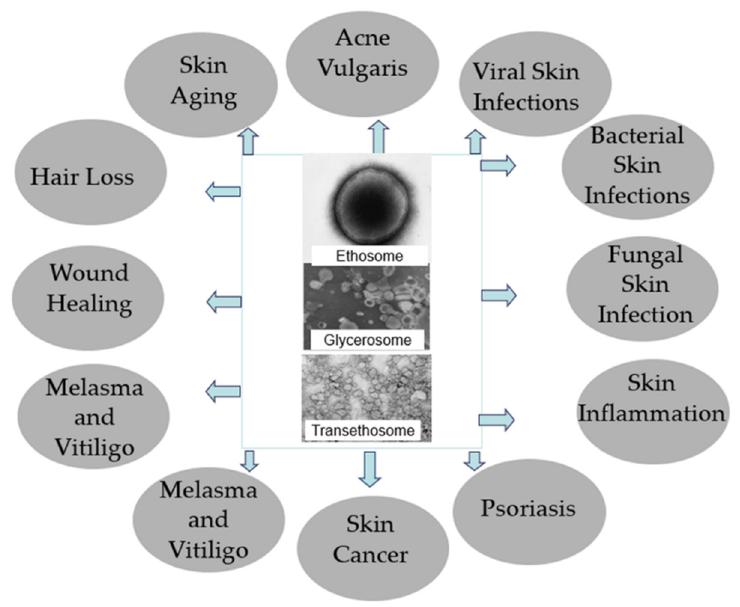
Figure 2. Skin disorders treated with topical drug delivery systems containing phospholipid soft vesicles.